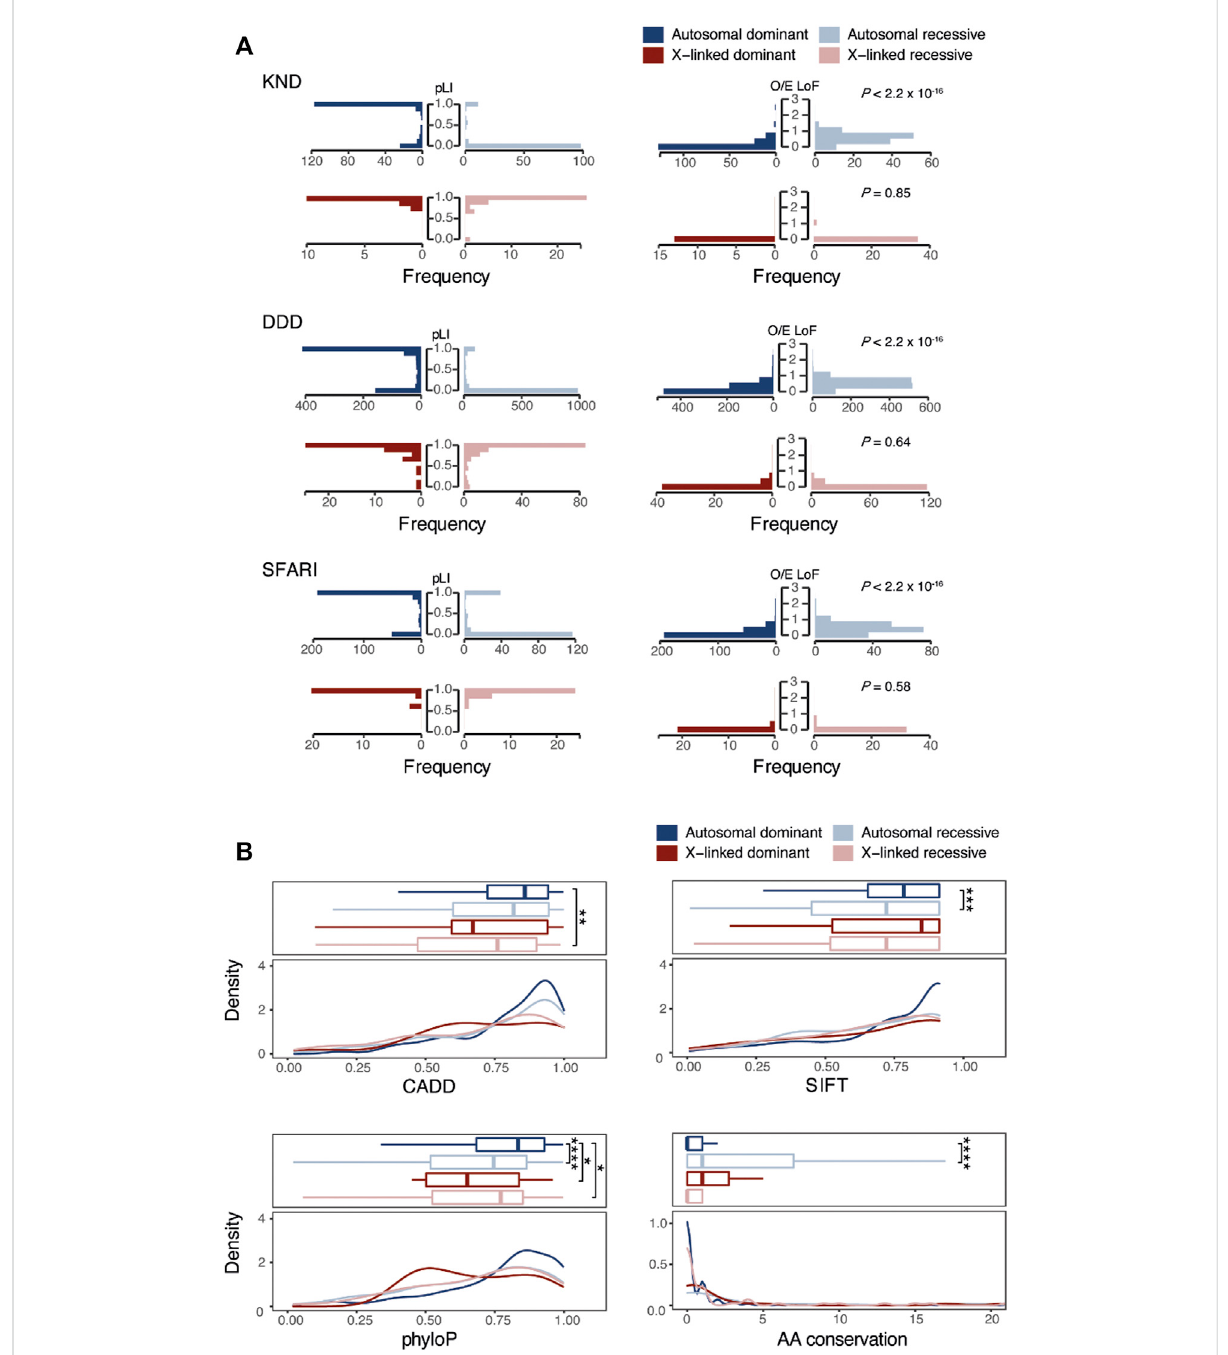
FIGURE 3 Comparison ofgeneticcharacteristicsofgenesandvariantsthatfollowdominantorrecessive inheritance. (A) Comparison ofpLIorO/Escores of NDD causal genes across inheritance patterns. (B) Comparison of functional (CADD, SIFT, and phyloP) and conservation scores among NDD causal variantsaccordingto inheritance patterns. “ AAconservation ” denotesthenumberofspecies withdifferentaminoacidsin99humanortholog proteins. *, p -value < 0.1, **, p -value < 0.01, ***, p -value < 0.001. ****, p -value <